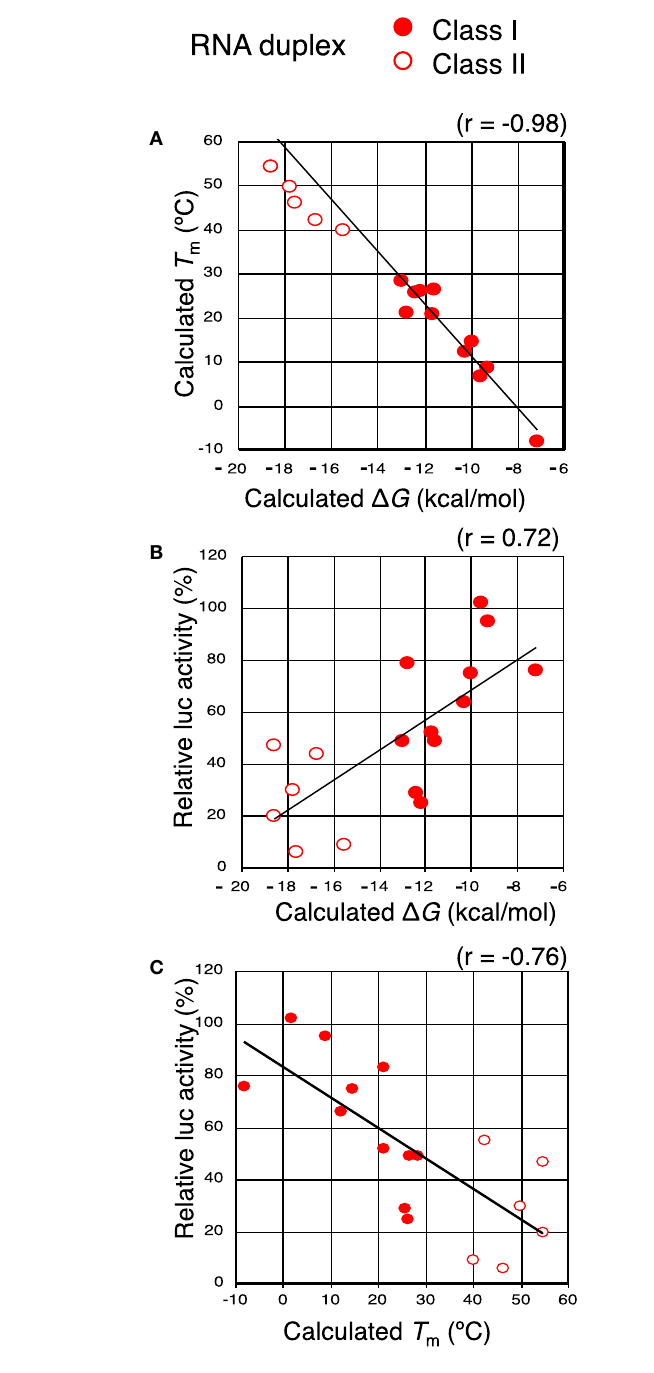
(seed-dependent off-target gene silencing at a 50nM siRNA concentration) was positively correlated with Δ G (correlation coefficient: 0.72 and 0.71, respectively). (C,F) The correlation between the seed-dependent gene silencing activity (luciferase activity) and the calculated T m of the seed-target duplex. Luciferase activity based on seed-dependent gene silencing with 50nM siRNA was obtained from Figures 4 and 7 , respectively. Seed-target duplex Δ G and T m were calculated using the nearest neighbor method.The relative luciferase activity and calculated T m were correlated with each other and had a coefficient of − 0.76 and − 0.79,